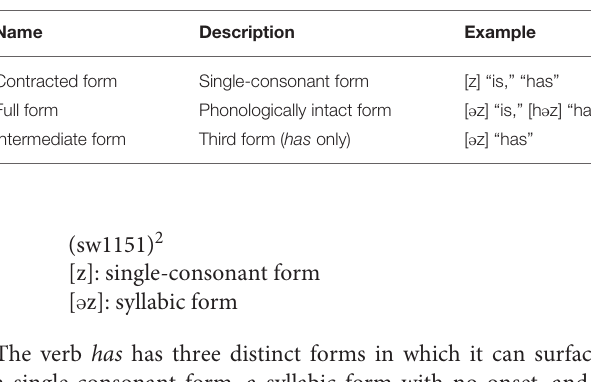
TABLE 1 | Forms of is and has